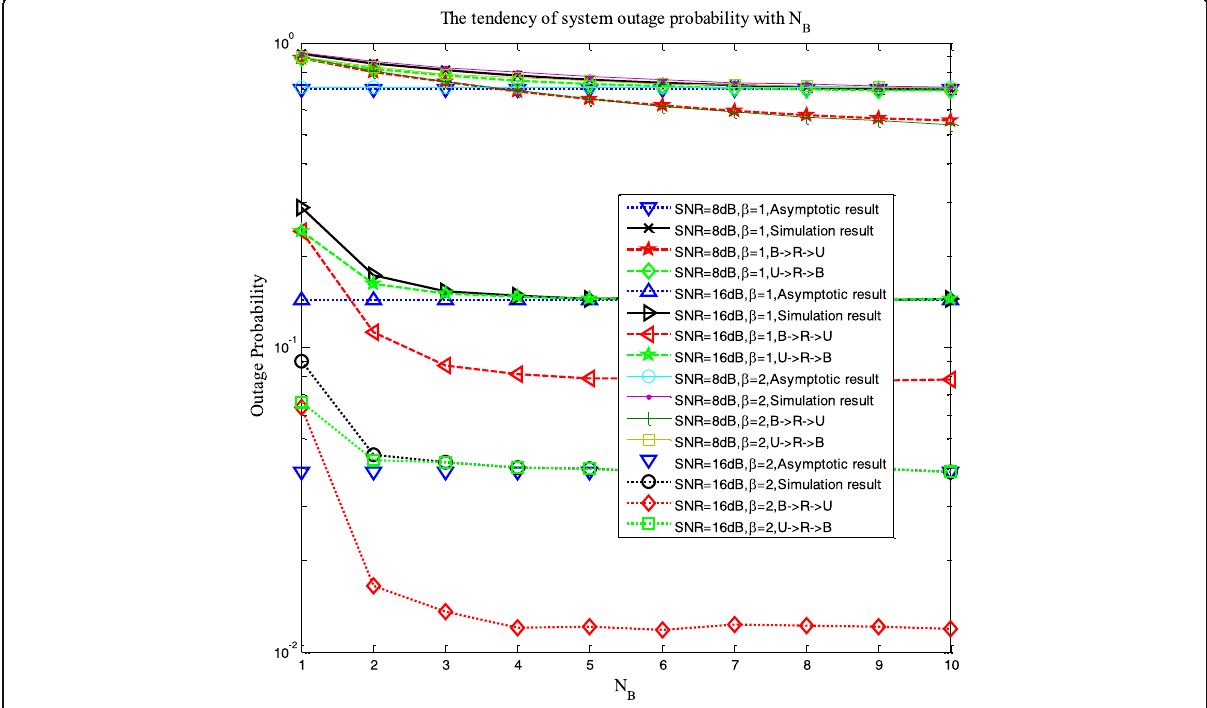
Fig. 3 The tendency of system outage probability with N B